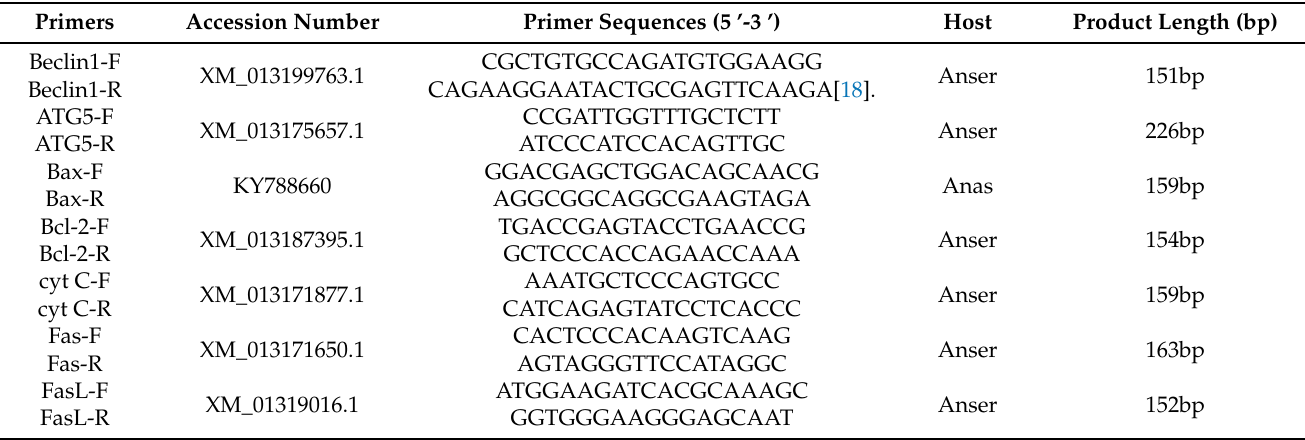
Table 1. Primers used in the study for real-time